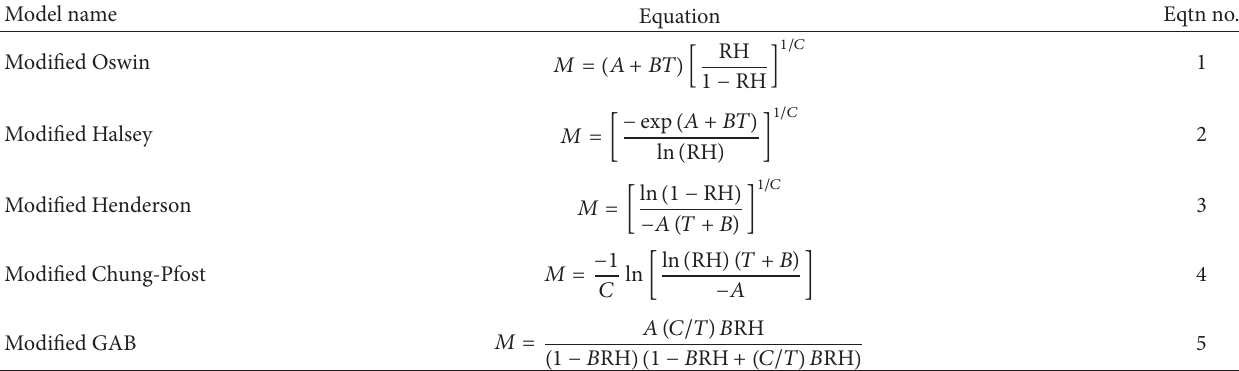
Table 2: The five most commonly used three-parameter isotherm equations for calculation of the equilibrium moisture content